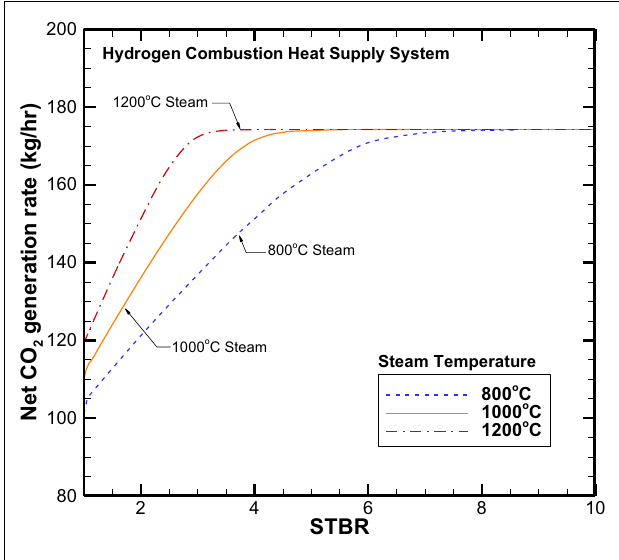
FIGURE 9 | Hydrogen recycled ratio for concept system I as a function of STBR